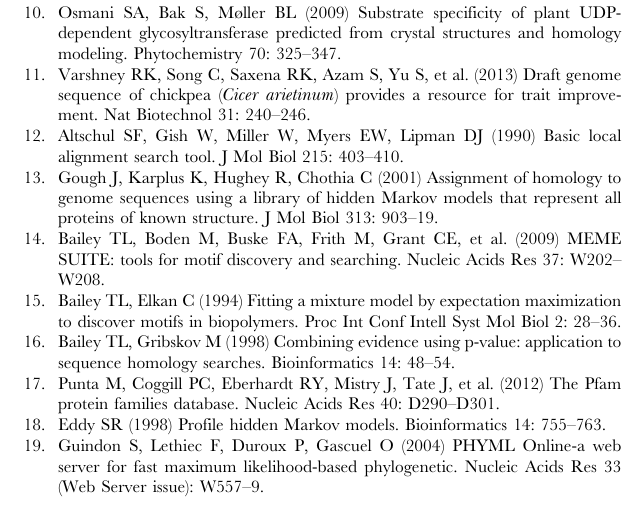
Table S1 Sequence information of 89 UGTs dataset. Table S2 Sequence information of 38 UGTs dataset. Table S3 Summary of 96 chickpea UGTs: information of genes and intron size, numbers, phase and positions. Table S4 Gene nomenclature of chickpea UGTs. Table S5 Functional specificity of chickpea UGTs. Table S6 Statistics of Blast results. Table S7 Structure evaluation statistics of generated homology models of Ca UGTs protein sequences. Table S8 Orthologs of chickpea UGTs in four selected dicot plants. Table S9 Standard deviation of protein lengths of Table S10 Expression values (FPKM) of all the chickpea UGT genes in various plant tissues. Table S11 Description of Cicer arietinum EST BLAST hits against the chickpea dbEST in